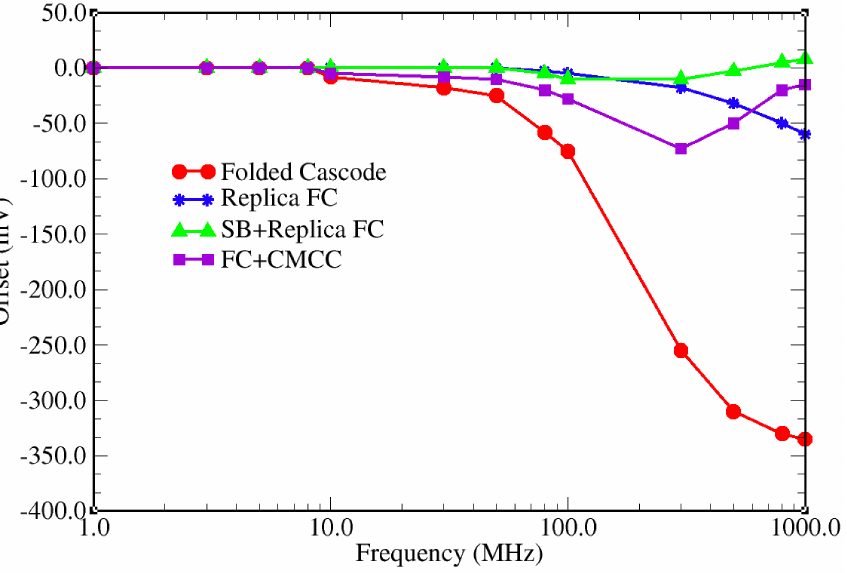
Figure 12. Offset induced by 1.65 Vpp EMI coupled to the output pin of FC amplifiers.